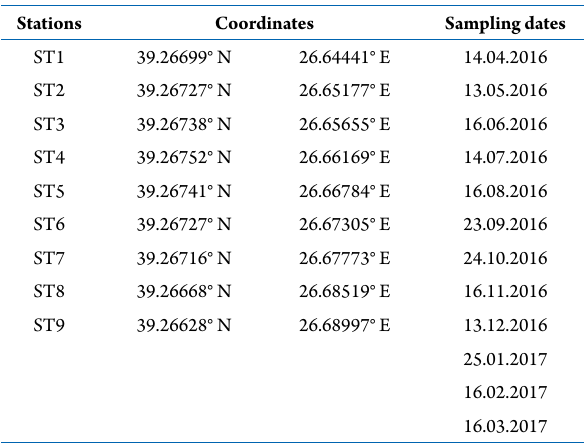
Table 1. Coordinates and sampling dates of the